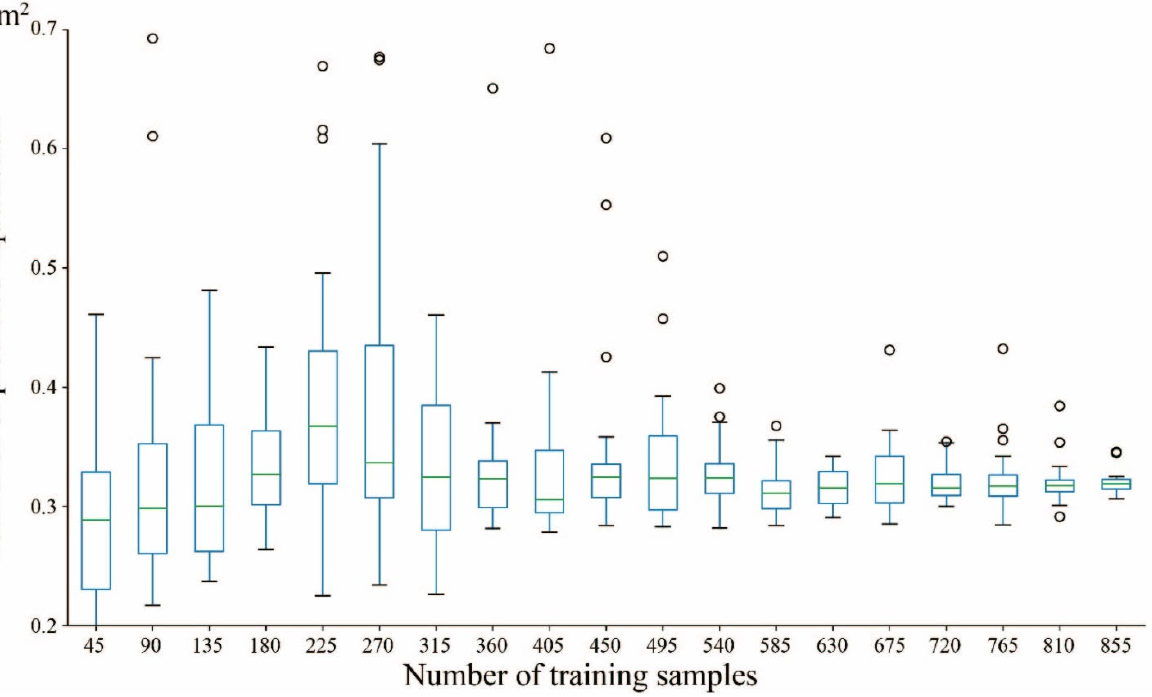
Figure 12. The relationship between the total area of extracted liquefaction by GBDT and the number of training samples. of training